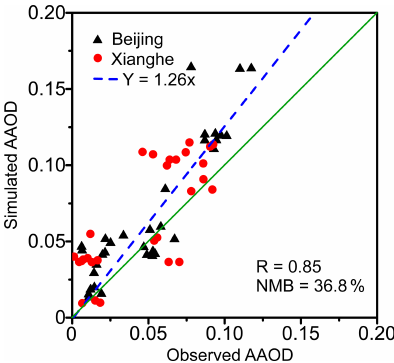
Figure 6. Comparison of simulated absorption aerosol optical depth (AAOD) at 550nm with observations at Beijing (39.98 ◦ N, 116.38 ◦ E) and Xianghe (39.75 ◦ N, 116.96 ◦ E) stations from 11 to 19 December